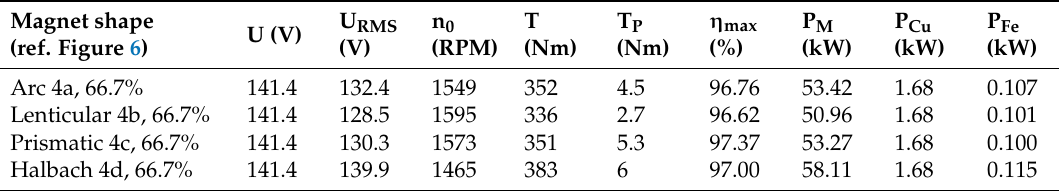
Table 2. The results of initial numerical calculations of the motor with concentrated coils with 17 turns of wire with a CSA of 12.8 [mm 2